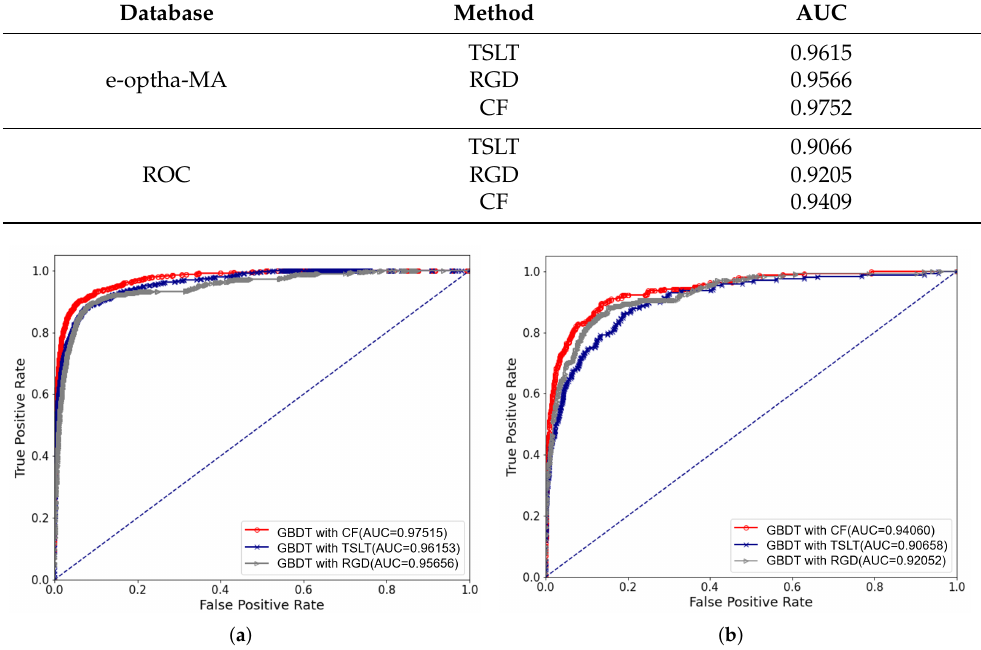
Table 5. Validation of different features in MA candidate classification.